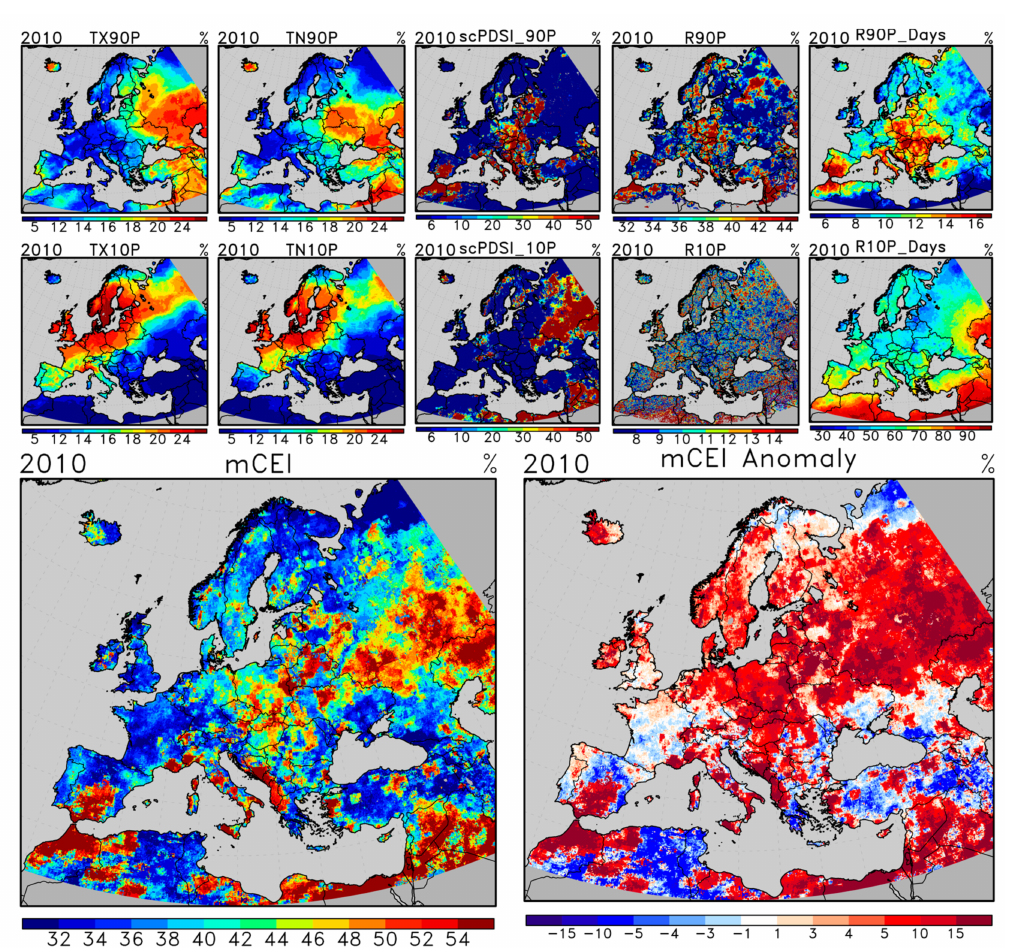
Figure 11. Extreme indexes, mCEI, and mCEI anomaly for